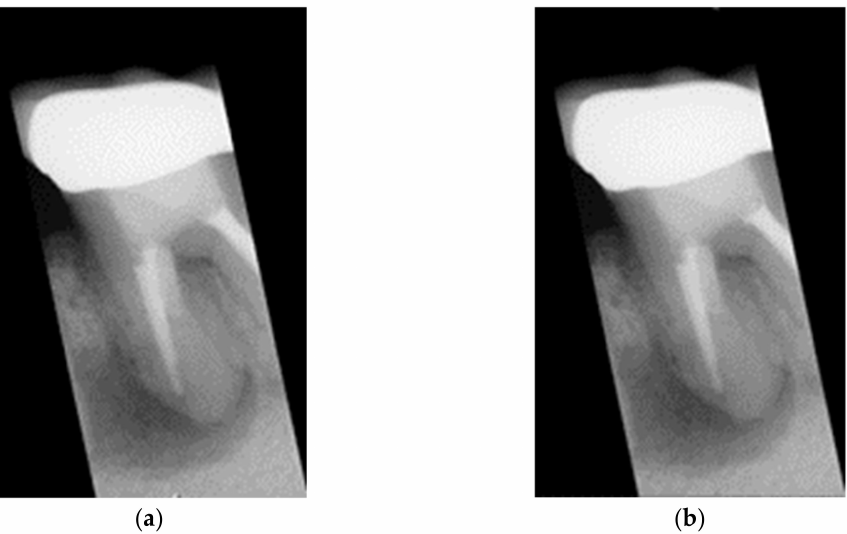
Figure 5. The results of the Gaussian high-pass filter. ( a ) original apical lesion image, ( b ) image after Gaussian